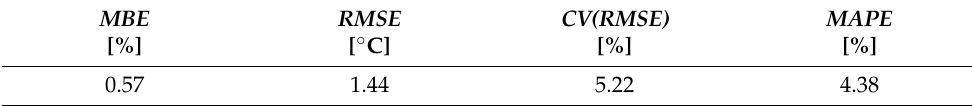
Table 3. Statistical parameters for the data from 18 May 2016–9 June 2016. MBE